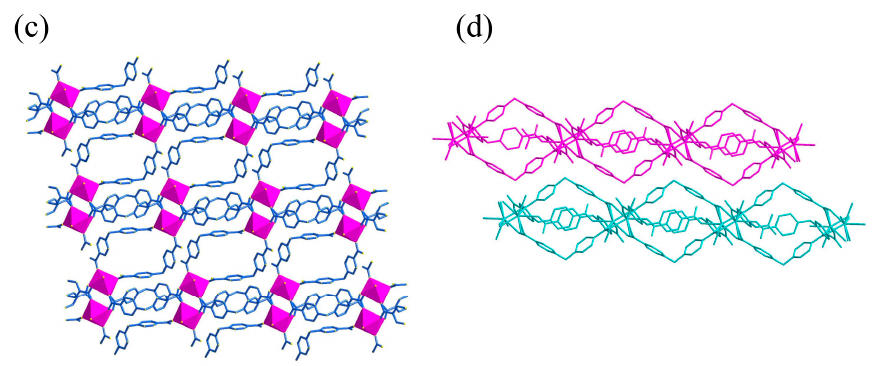
Figure 1. ( a ) Coordination environment of the La 3+ ion center. Symmetry codes: (A) A –x + 1, − y + 1, − z + 1; (B) –x + 2, -y + 2, − z + 2; (C) –x + 1, − y + 1, − z + 2; (D) x + 1, y + 1, z. ( b ) Two adjacent La 3+ ions are bridged by four carboxylate groups from four L ligands. ( c ) 2D network of compound 1 . ( d ) 3D supramolecular structure of compound 1 .